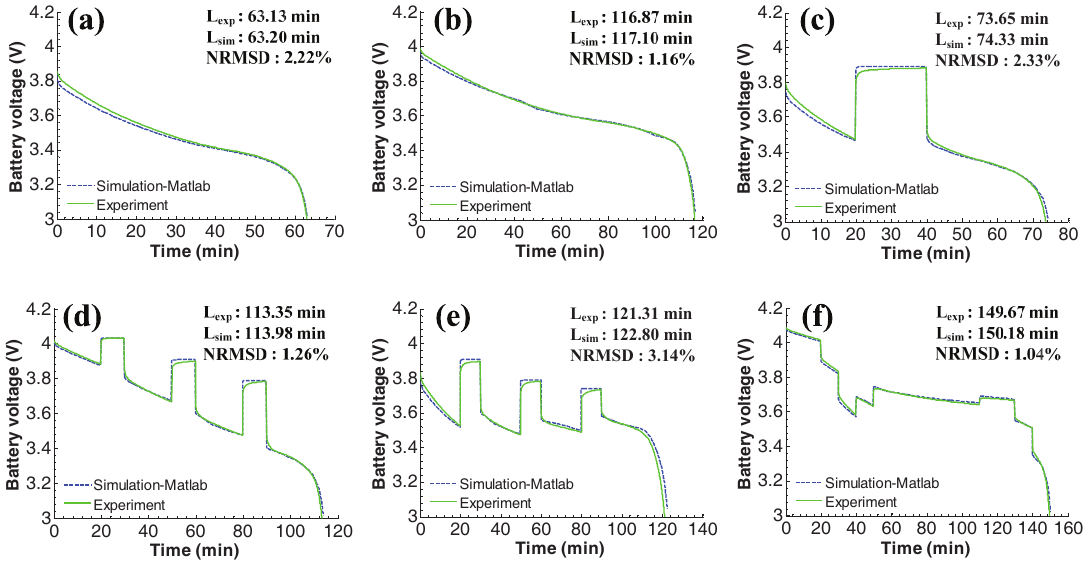
Figure 12. Model validation by MATLAB simulations: ( a ) heavy load ( P 1 ); ( b ) light load ( P 2 ); ( c ) interrupted load ( P 3 ); ( d ) increasing load ( P 4 ); ( e ) decreasing load ( P 5 ); ( f ) varying load ( P 6 ).